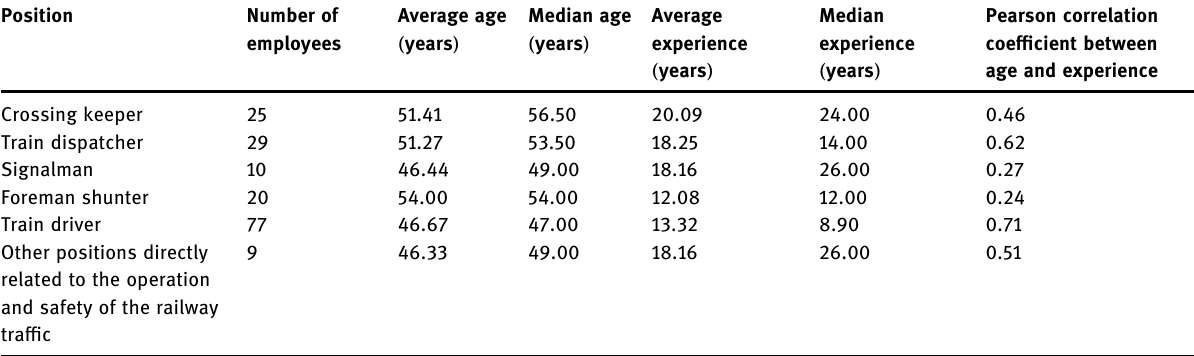
Table 1: Employees involved in accidents and incidents: age and experience structure [ 17 ]